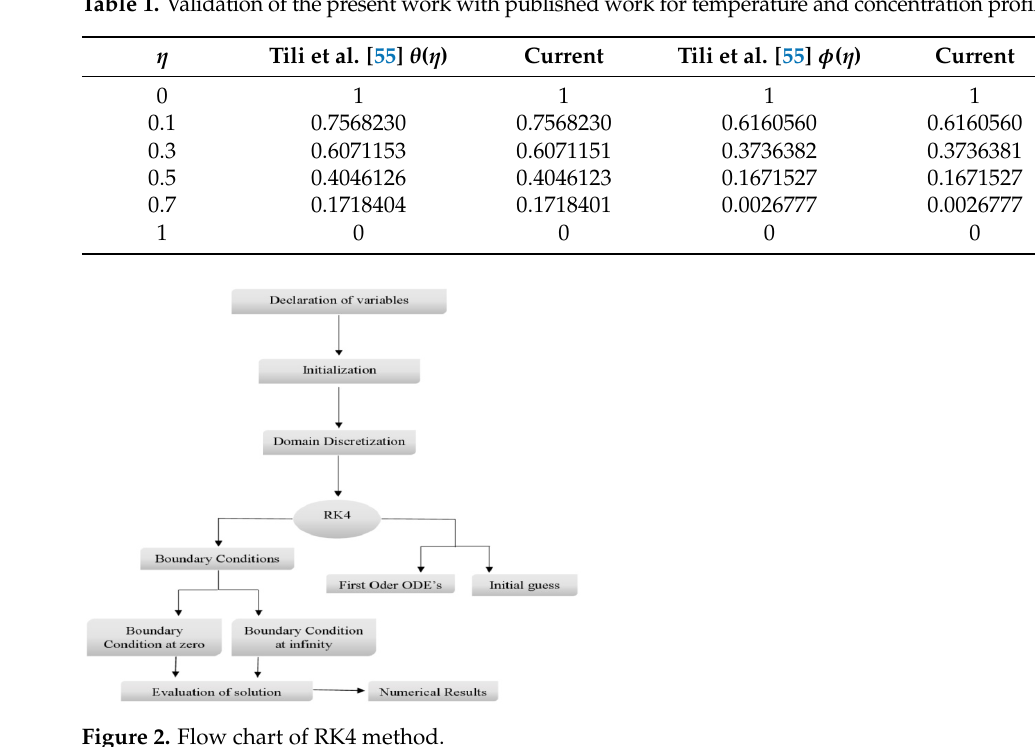
Table 1. Validation of the present work with published work for temperature and concentration profiles.